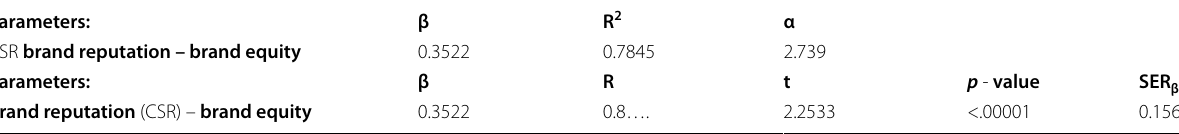
Table 8 SEM: CSR mediating from brand reputation translation to brand equity relationship Parameters: β CSR brand reputation – brand